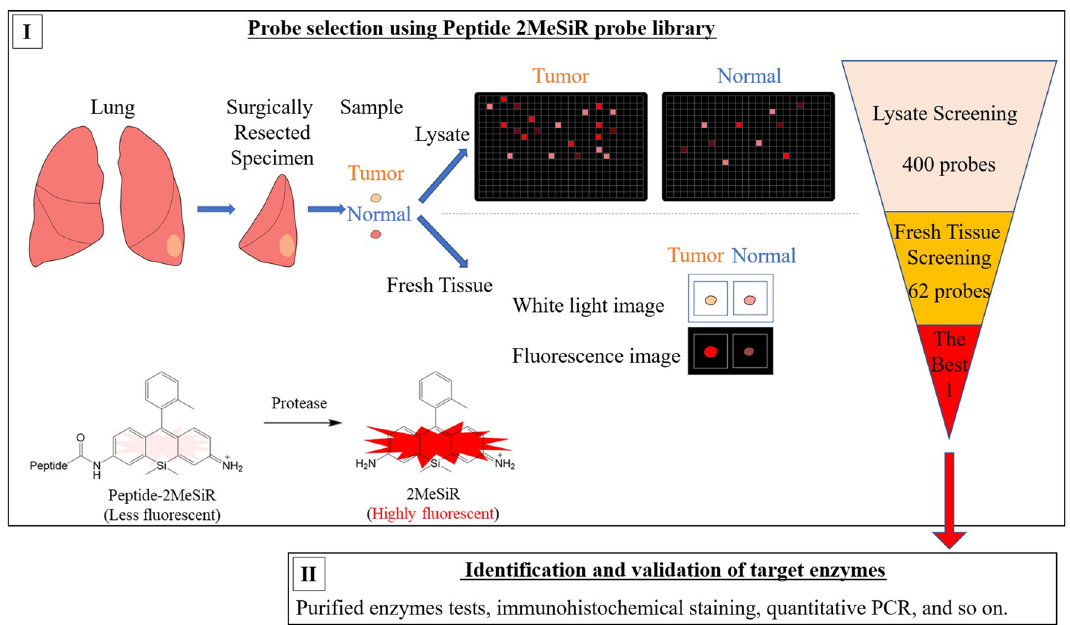
Figure 1. Schematic illustration of work-flow. ( I) Lung cancer surgery specimens were used to screen a library of 400 2MeSiR-based probes. ( II) After modification of the selected probe to improve the performance (see the text), the target enzymes were identified and validated using multiple